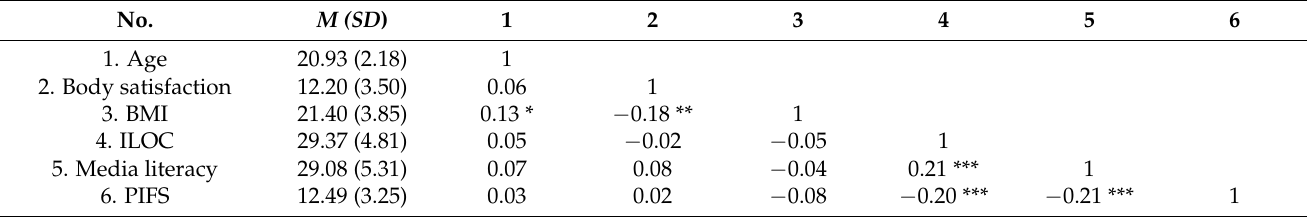
Table 2. Means, standard deviation and correlations among